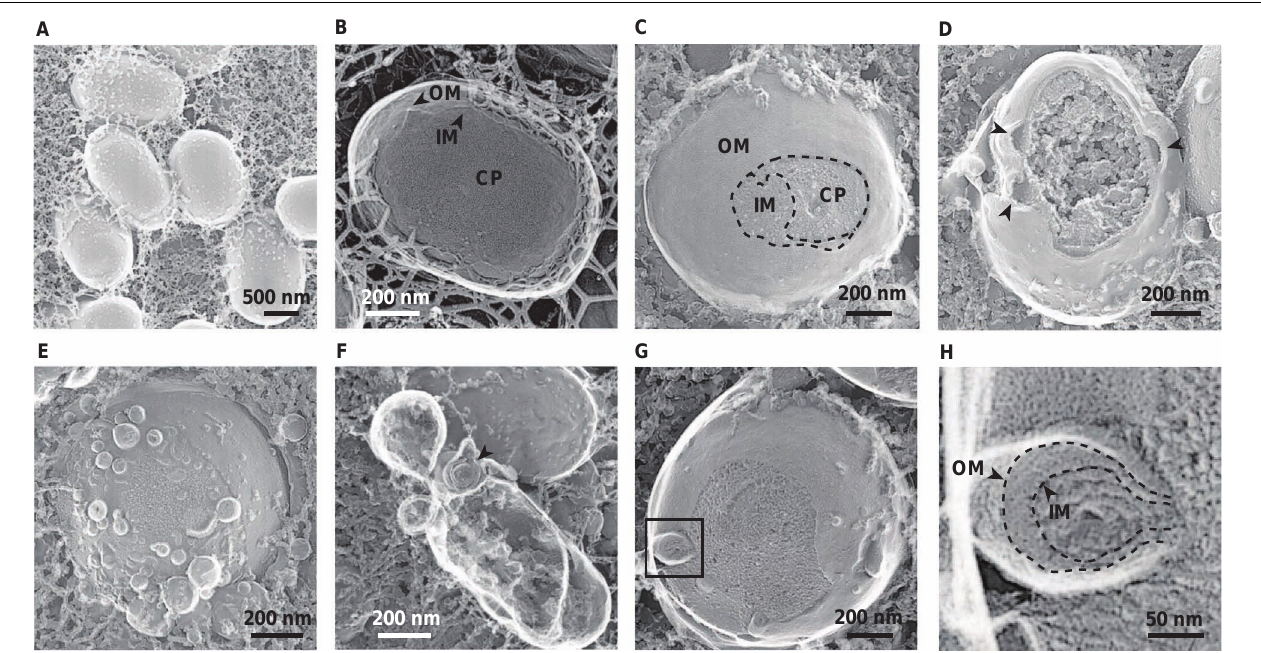
FIGURE 7 | Visualization of bacterial surfaces by quick freeze deep-etch and replica electron micrograph (QFDE-EM) analyses. E. coli BW25113 was grown in LB in the absence (A,B) and presence (C–H) of 1% glycine. The outer membrane (OM), inner membrane (IM), and cytoplasm (CP) are shown (B,C) . The black arrows indicate loose and curved OM portions (D) and double lamellar vesicles (F) , respectively. Enlarged image of the black box in image (G) are shown in image (H) .